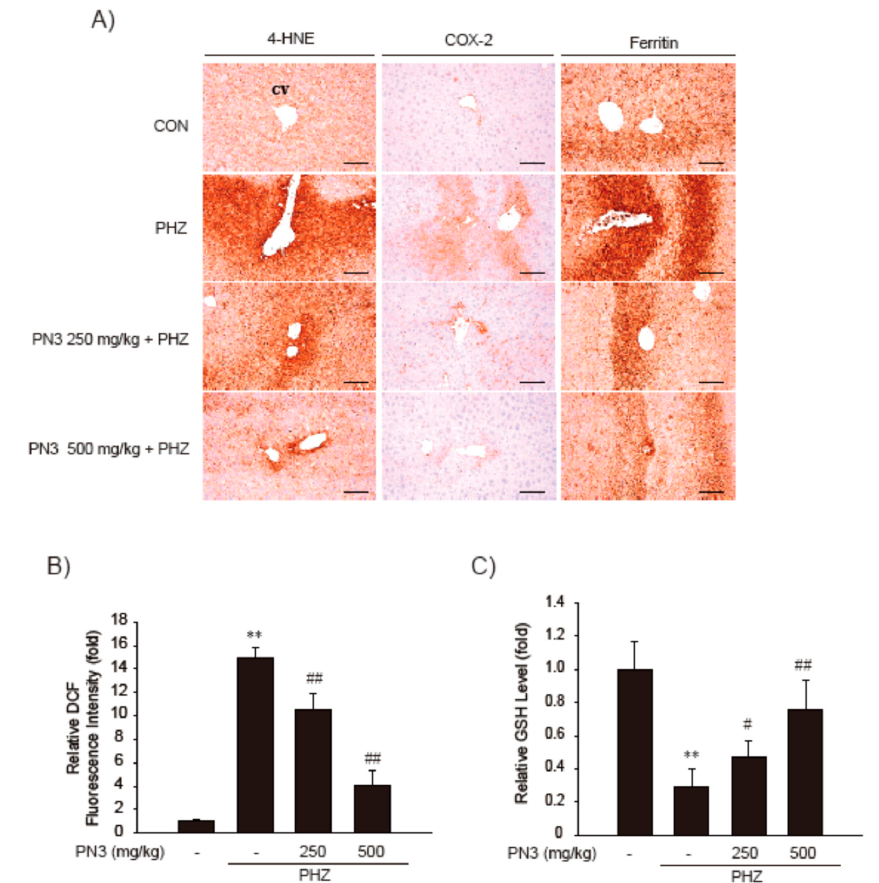
Figure 7. The effect of the ethyl acetate fraction PN3 on PHZ-induced liver injury. ( A ) The observation of 4-HNE, COX-2, and ferritin immunostained hepatocytes. ( B ) Determination of ROS generation in mice liver. After frozen livers were stained with 5 µ M DCFH-DA, ROS levels were measured by a fluorescence microplate reader. ( C ) Measurement of GSH. GSH concentration was measured in mouse liver homogenates. Data represent the mean ± S.D.; ** p < 0.01, significant versus vehicle-treated control; # p < 0.05, ## p < 0.01, significant versus PHZ